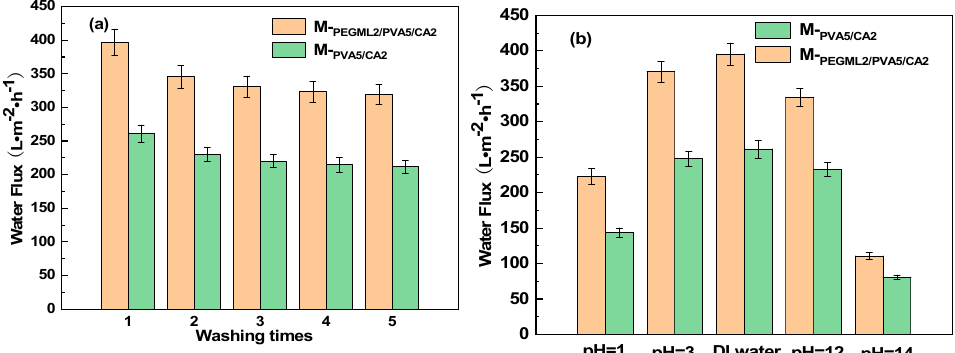
Figure 11. ( a ) The relationship between the number of cleaning and water flux; ( b ) water flux testing in different chemical environments .